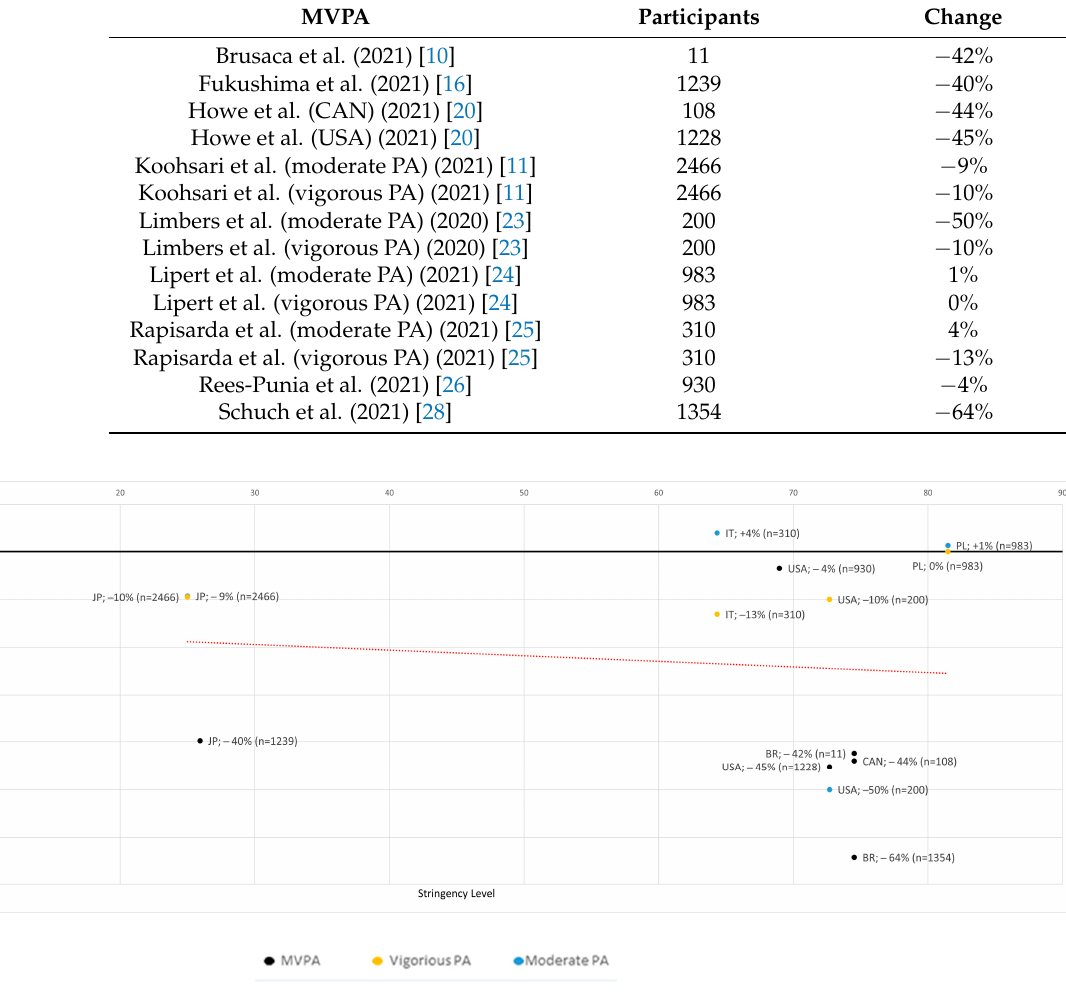
Figure 3. Moderate to vigorous PA to stringency level with trend line (red) [10,11,16,20,23–26,28]. Table 7. Change in moderate to vigorous